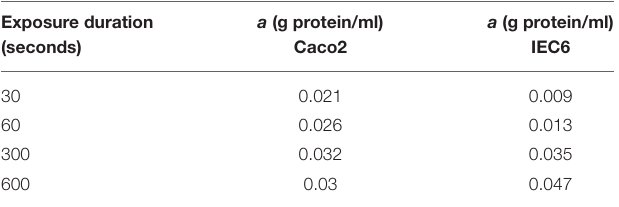
TABLE 4 | Best fit values of the protein density ( a ) used to generate the simulated curves in Figure 5 for different exposure times and both cell lines. Exposure duration a (g protein/ml) a (g protein/ml) (seconds) Caco2